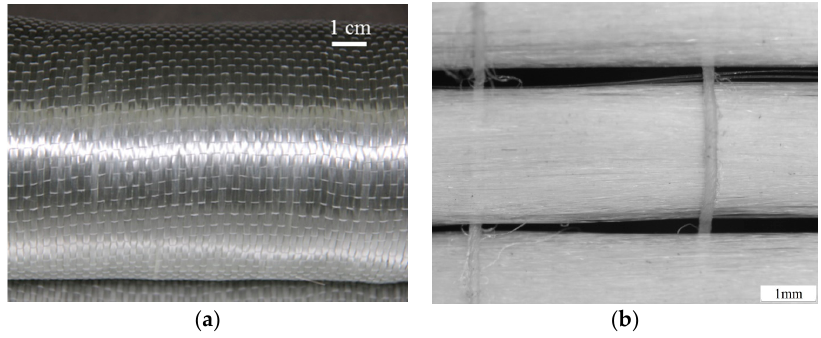
Table 1. Physical and Mechanical Properties of GFRP components (The mechanical properties of glass yarn are obtained under quasi-static loading condition and gauge length of specimen is 25 mm.